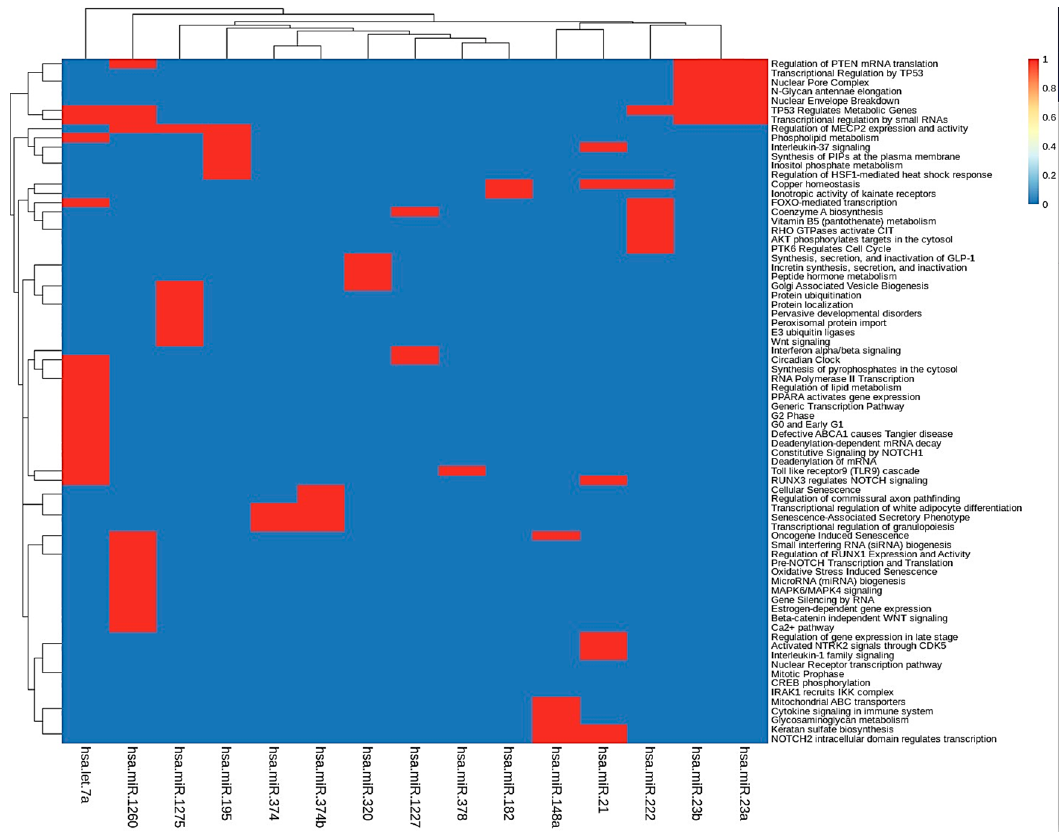
Figure 5. KEGG pathway enrichment analyses were performed to identify miRNA dysregulated pathways using their target dysregulated genes in the MGDRNs. The heatmap of the pathways as a function of miRNAs is shown; bidirectional hierarchical clustering was performed using the R package.